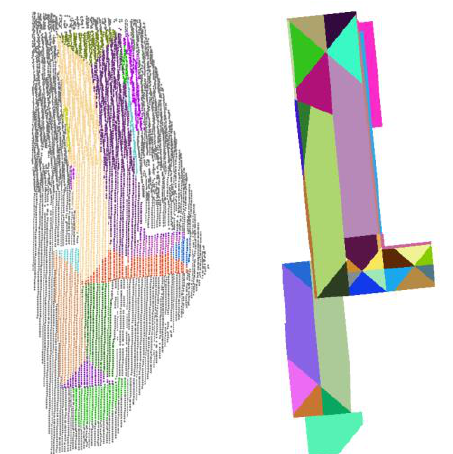
Figure 4. Left: The result of the segmentation. Right: The result of the binary space partitioning without considering building knowledge.